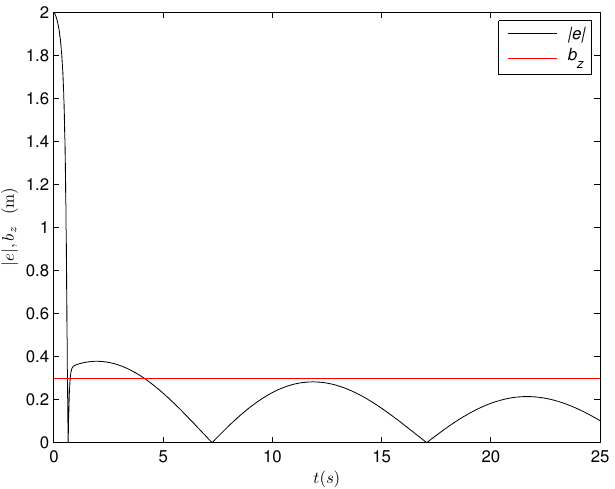
Figure 8. Absolute value of surge position tracking error (traditional adaptive control).